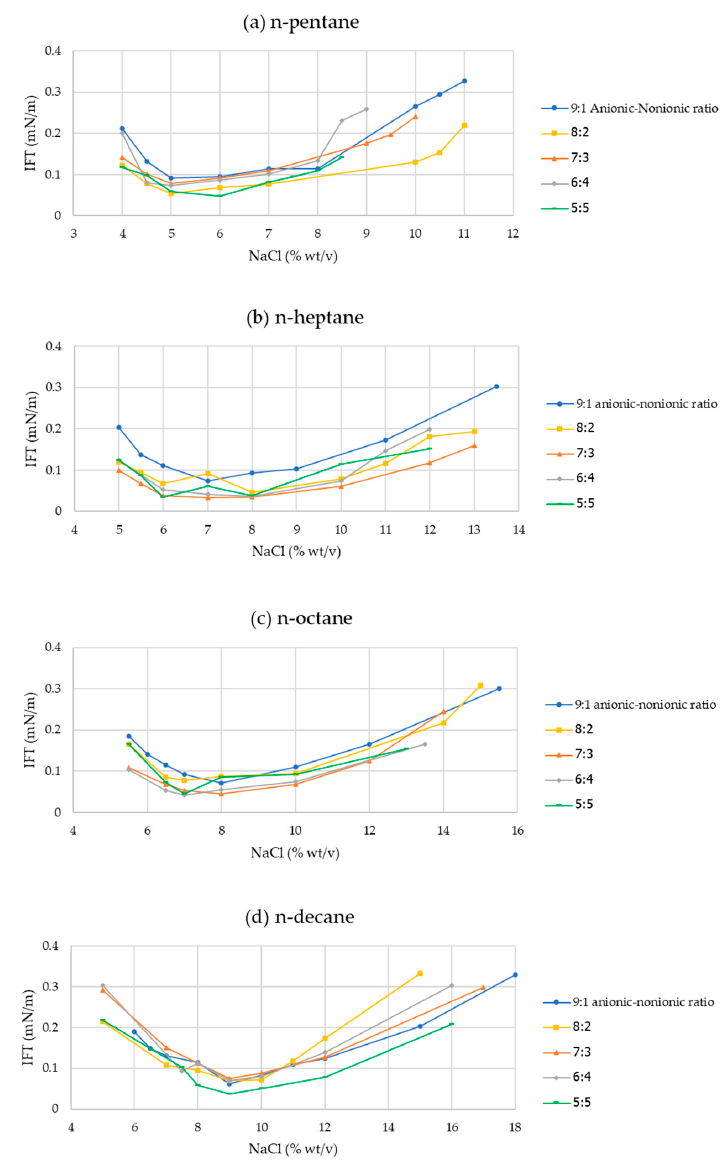
Figure 4. Interfacial tensions (IFTs) of SDHS-AAE(6EO4PO) systems with ( a ) n-pentane, ( b ) n- heptane, ( c ) n-octane, and ( d ) n-decane. Table 2. Optimal salt concentrations (S*) and optimal interfacial tensions (IFT*) of SDHS-AAE(6EO4PO) systems. Anionic–Nonionic Ratio